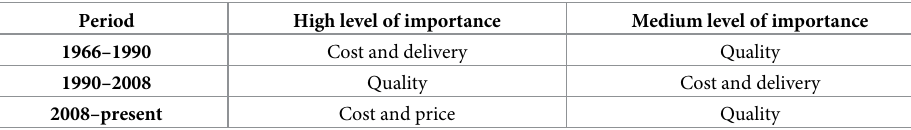
Table 1. Criteria relative importance